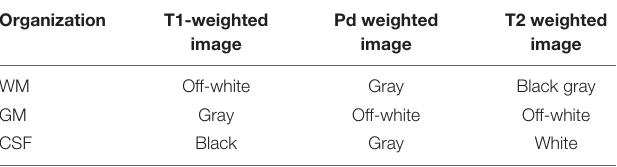
TABLE 1 | Image grayscale characteristics of adult brain